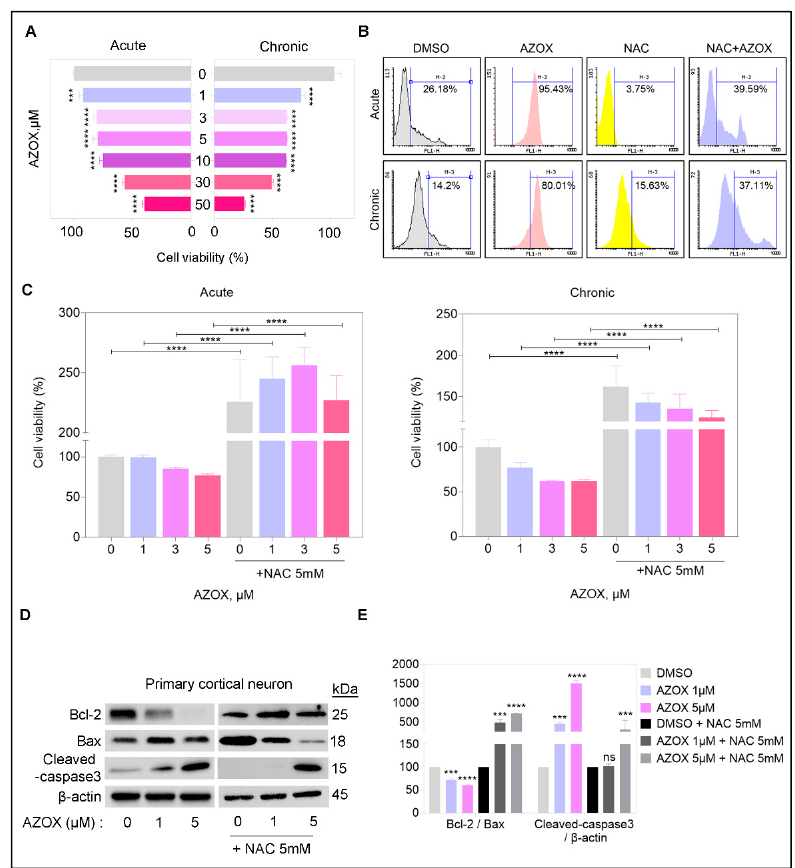
Figure 1. Cytotoxicity of AZOX in primary cortical neurons ( A ) AZOX was exposed to primary cortical neuronal cultures (stage E15.5) for a short interval (acute-24 h) and a long interval (chronic- 7 days). Cell viability assay was performed in primary neurons exposed to different concentrations of AZOX. The 50% inhibitory concentration (IC50) for AZOX was 30 µ M for acute treatment, and 10 µ M for chronic exposure for 24 h (acute exposure). ( B ) ROS generation in the primary neurons, quantified by oxidized DCFDA by flow cytometry. ( C ) Pre-exposure of NAC revived the viability in AZOX treated primary neurons. ( D , E ) Quantification of the protein expression of apoptotic related markers Bcl-2/Bax ratio and cleaved caspase 3 in AZOX and AZOX + NAC treated primary neurons. The histograms represent the band intensity, data are presented as mean ± SEM; t -test: *** p < 0.001, **** p < 0.0001. β -actin was used as the loading